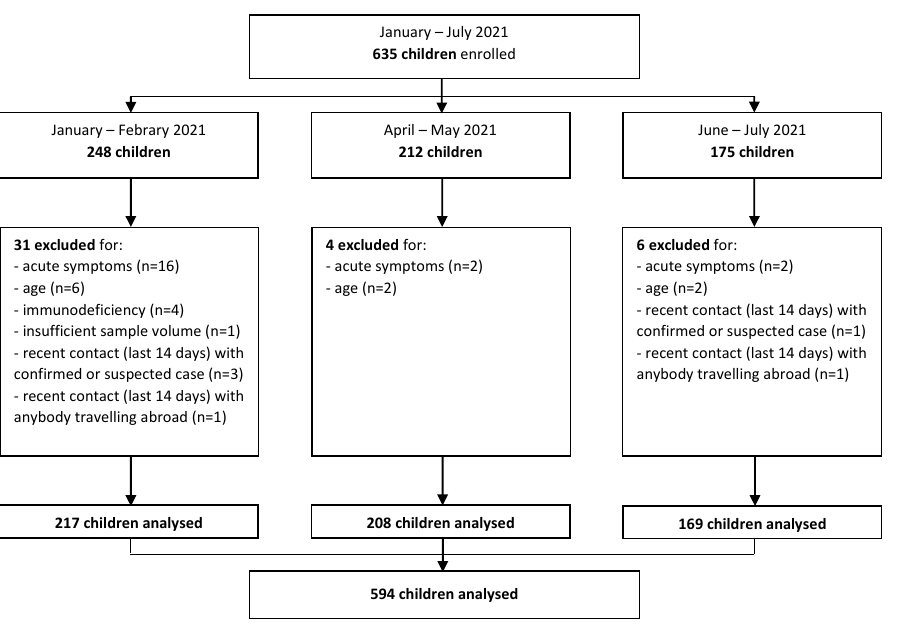
Figure 1. Study flow diagram.